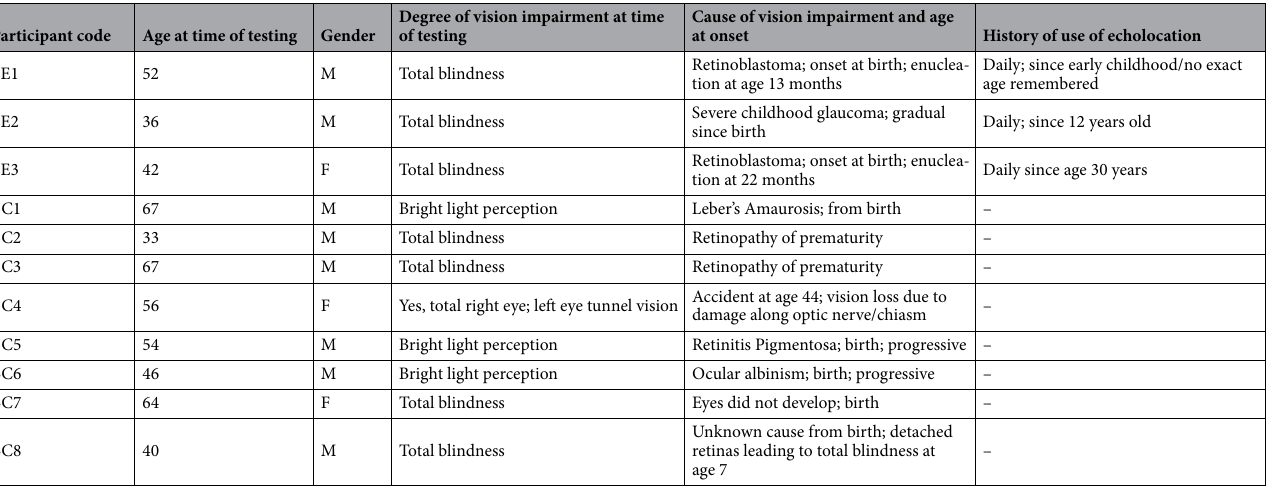
Table 1. Details of blind participants who took part in the study. EE expert echolocator, BC blind